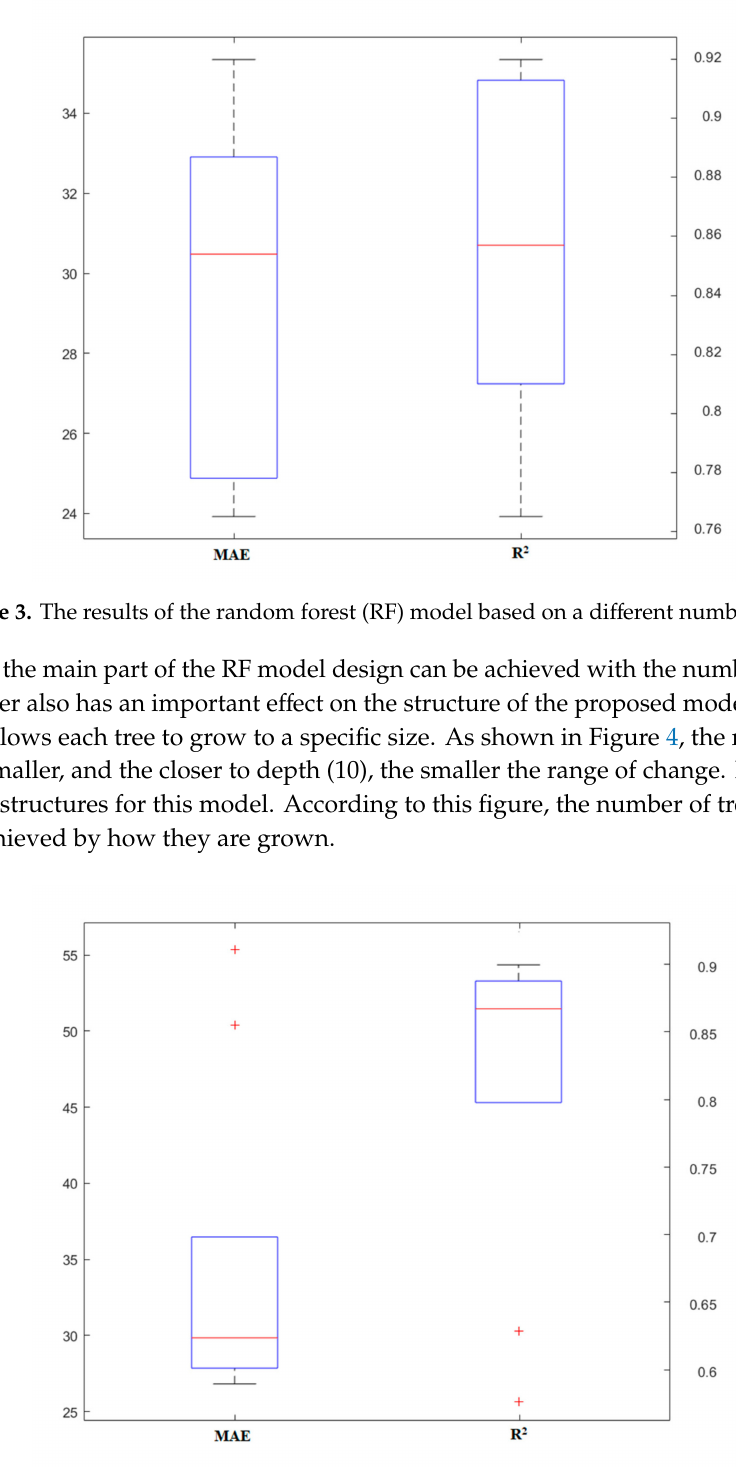
Figure 4. The results of the RF model based on the depth of the